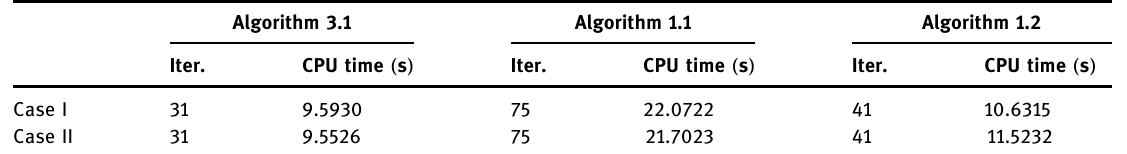
Algorithm 3.1 Algorithm 1.1 Algorithm 1.2